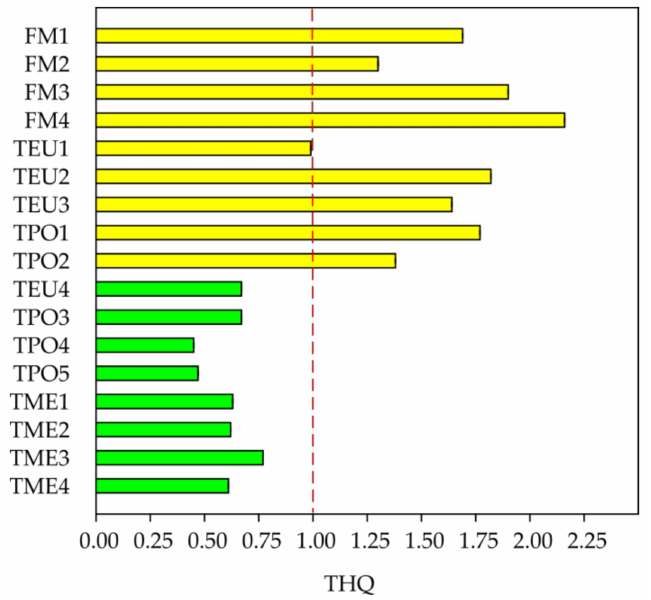
Figure 6. THQ in the water bodies of the Grado (yellow) and Marano (green)